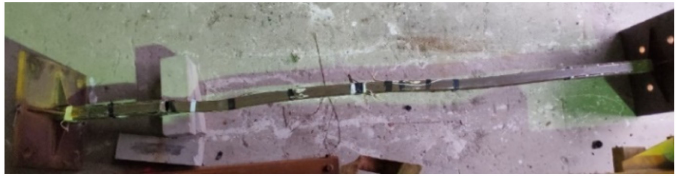
Figure 8. Failure mode of the core